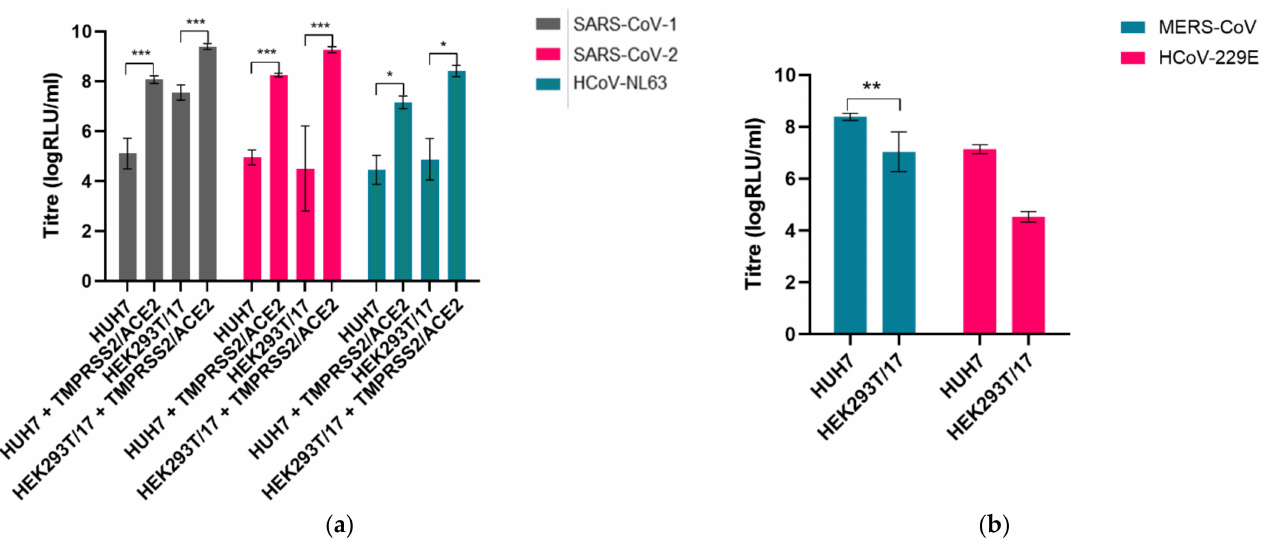
Figure 7. Entry of PVs was assessed by titration into various cell lines. ( a ) Entry of SARS-CoV-1 was highest in HEK293T/17 cells, whilst entry of SARS-CoV-2 and HCoV-NL63 was comparable in both HEK293T/17 and HUH7 cells. ( b ) MERS-CoV and HCoV-229E preferentially entered HUH7 cells compared to HEK293T/17 cells. Significant differences in titre shown by asterisks: * represents p ≤ 0.05, ** p ≤ 0.005 and *** p ≤ 0.0005,